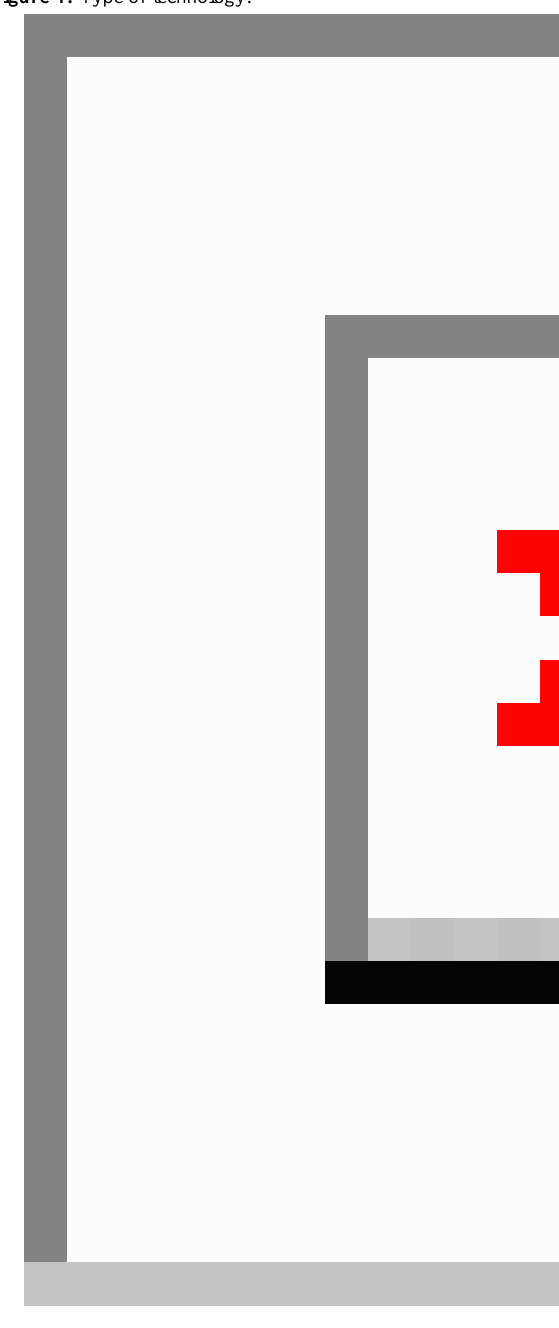
Figure 4. Type of